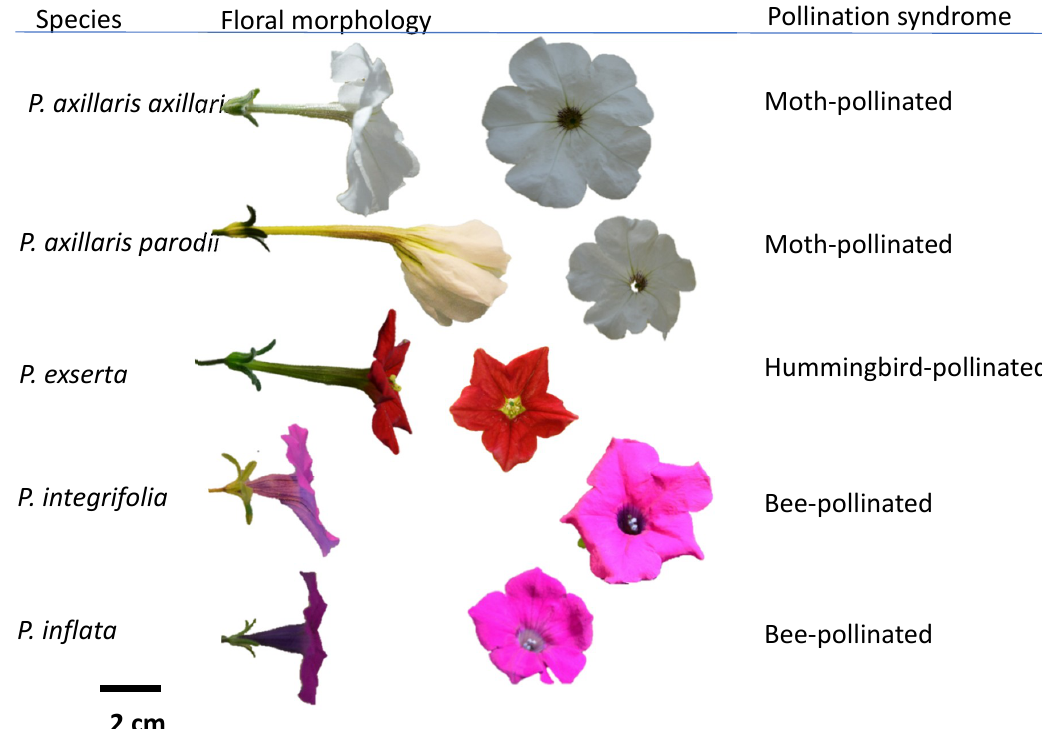
Figure 2. Flower size and morphology in five species and subspecies of Petunia . The pollination syndrome characteristic of each taxon is shown in the column on the right. The scale bar equals two centimeters.